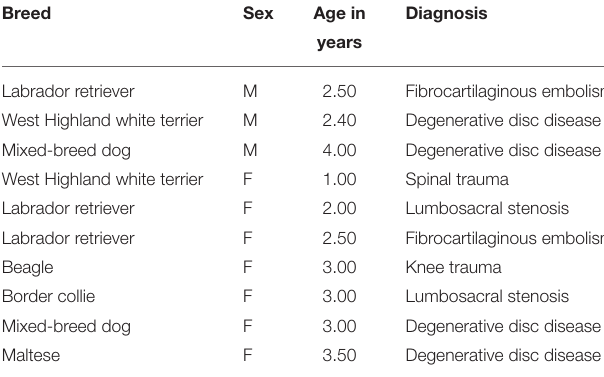
TABLE 2 | Dogs included in the control group. Breed Sex Age Days from the Duration of years last epilepsy in generalized seizure